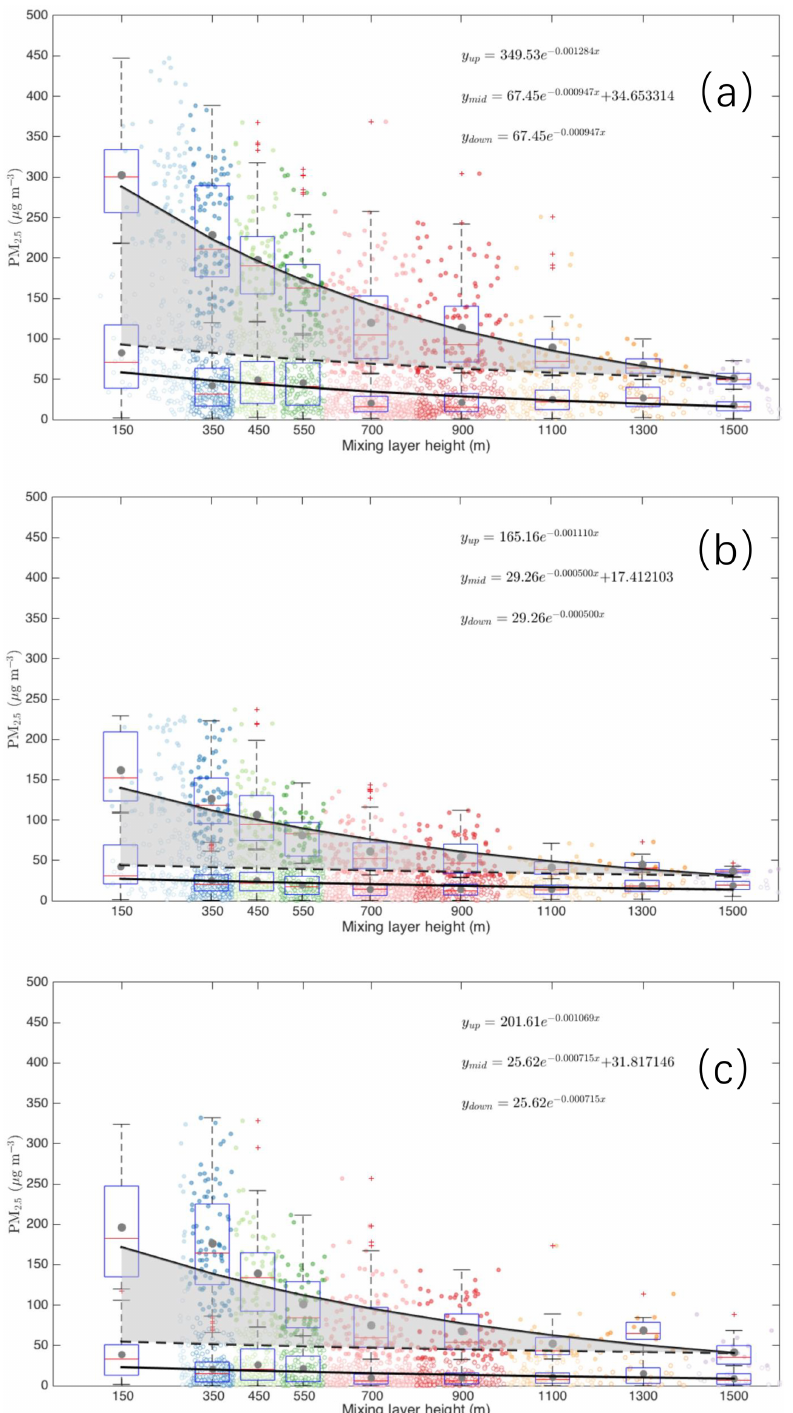
Figure 4. The variability of the PM 2 . 5 mass concentration as a function of the mixing layer height at 8m (a) , 120m (b) and 280m (c) . The data related to the upper fitting line represent PM 2 . 5 concentrations larger than 75µgm − 3 , while the data related to the lower fitting line represent PM 2 . 5 concentrations less than 75µgm − 3 . The dark grey points represent mean values; the red line represents median values. The shadowed area corresponds to an increased amount of PM 2 . 5 with decreased mixing layer height assuming that PM 2 . 5 has the same variation pattern under highly polluted conditions as in less polluted